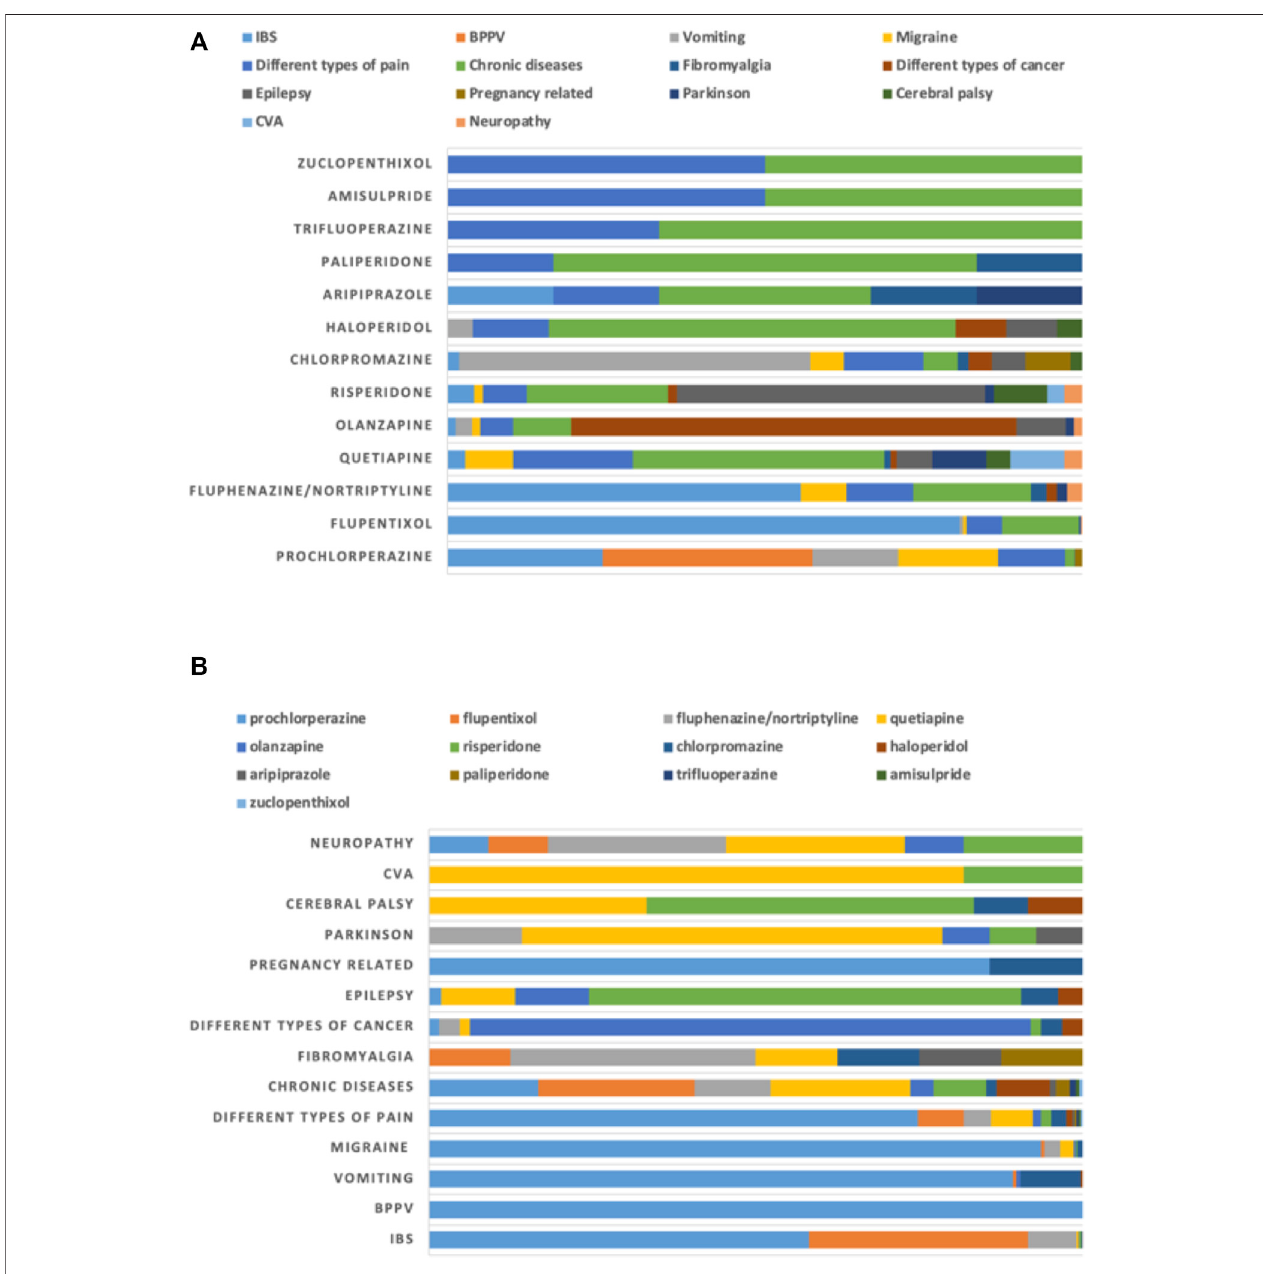
FIGURE 4 | Proportion of use of antipsychotics for non-mental health disorders (non-MHDs) strati fi ed by (A) diagnoses and (B) drugs.